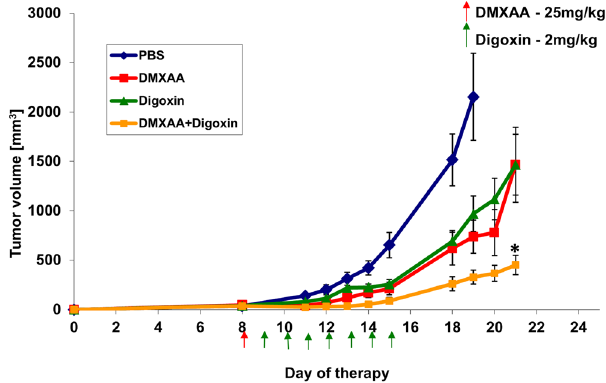
Figure 1. Treatment of mice bearing B16-F10 tumors with DMXAA and digoxin. DMXAA was administered once (25 mg/kg) and digoxin 7 times (2 mg/kg). Inhibition of tumor growth was statistically significant ( * p < 0,05) after administration of combined